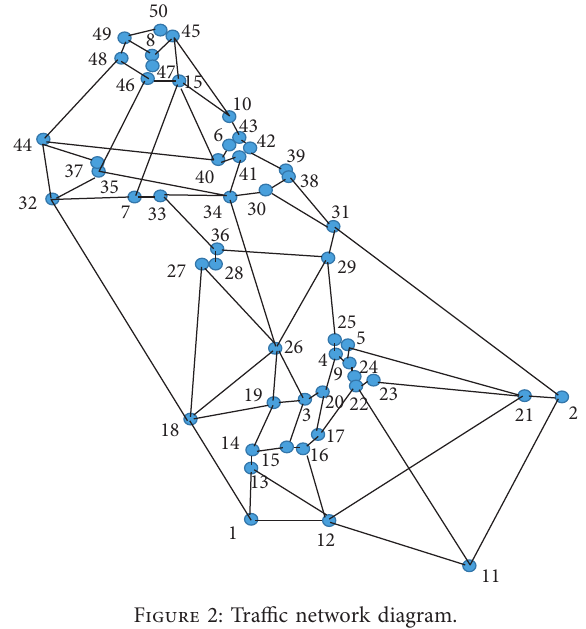
Figure 2: Traffic network